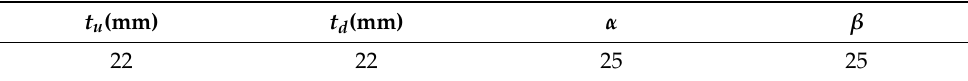
Table 4. Parameters most prone to calculation errors.